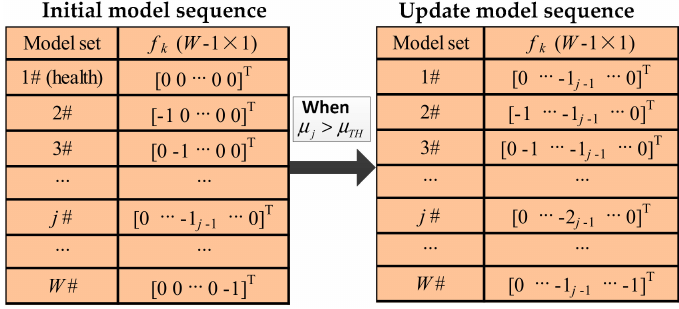
Figure 1. Demonstration of the hypothetical model set update.